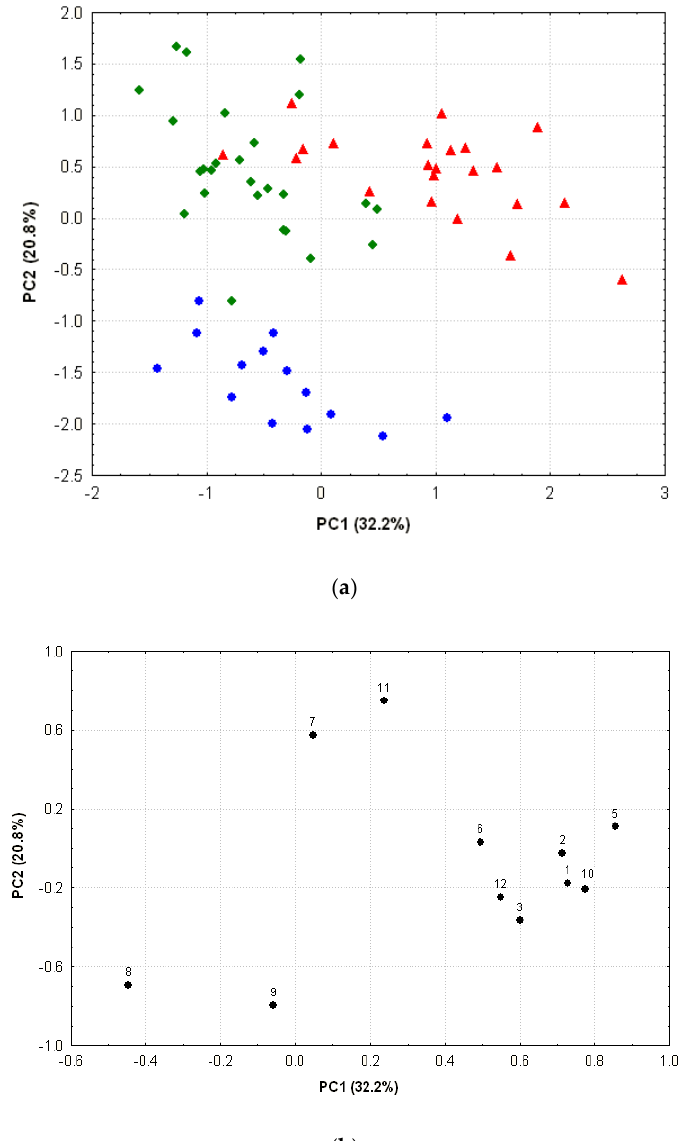
Figure 2. ( a ) Score plot of PCA along the two main components performed on NMR data regarding 62 olive oil samples, produced during three harvesting years labelled as blue circles, green diamonds, red triangles according to the respective year time order. The eleven variables with the highest discrimination power selected by ANOVA were used for the PCA and labelled by the Arabic numbers 1 – 3 and 5 – 12 (explained in the text); these are displayed in the ( b ) analogous plot of loadings.